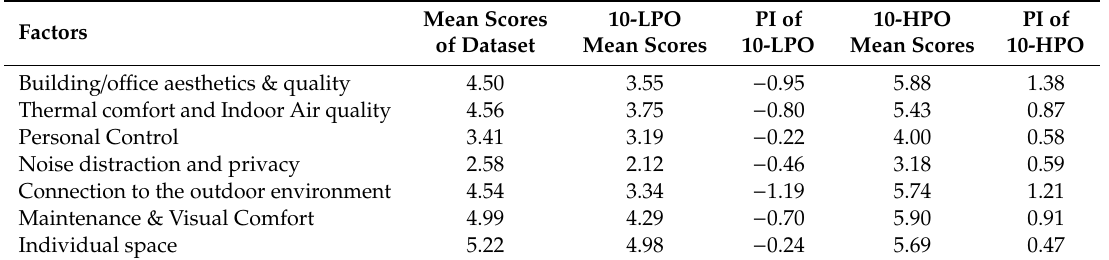
Figure 1. Mean scores of each factor for the dataset ( n = 9794), 10-LPO, and 10-HPO (7 is the highest score and 1 is the lowest). Table 4. Mean scores and performance index (PI) values of 10-LPO and 10-HPO.